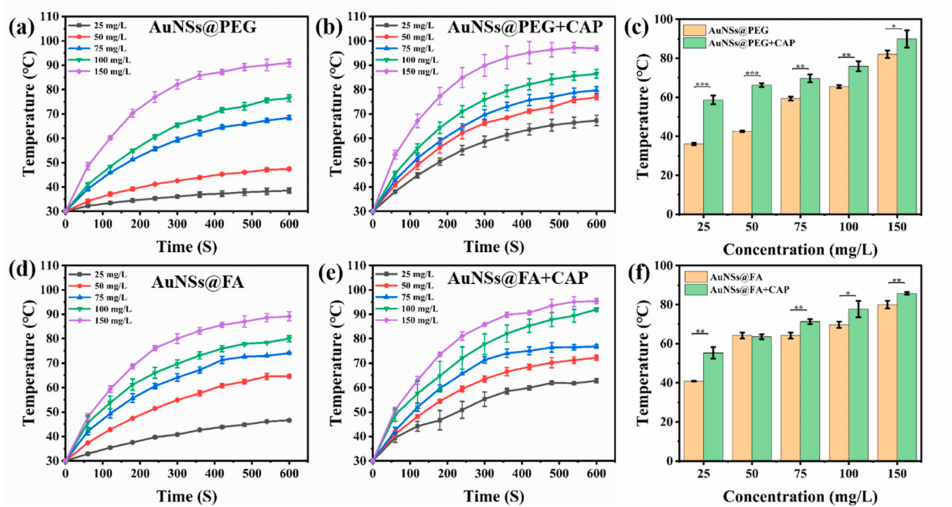
Figure 2. Increasing temperature curves of ( a ) AuNSs@PEG, ( b ) AuNSs@PEG+CAP, ( d ) AuNSs@FA, and ( e ) AuNSs@FA+CAP at different concentrations of Au irradiated for 600 s by 1.5 W/cm 2 808 nm laser irradiation. Contrast charts of ( c ) AuNSs@PEG and ( f ) AuNSs@FA at different concentrations of Au irradiated at 300 s by 1.5 W/cm 2 808 nm laser irradiation. * p <0.05 was considered statistically significant. ** p <0.01 and *** p <0.001 were considered highly statistically significant.